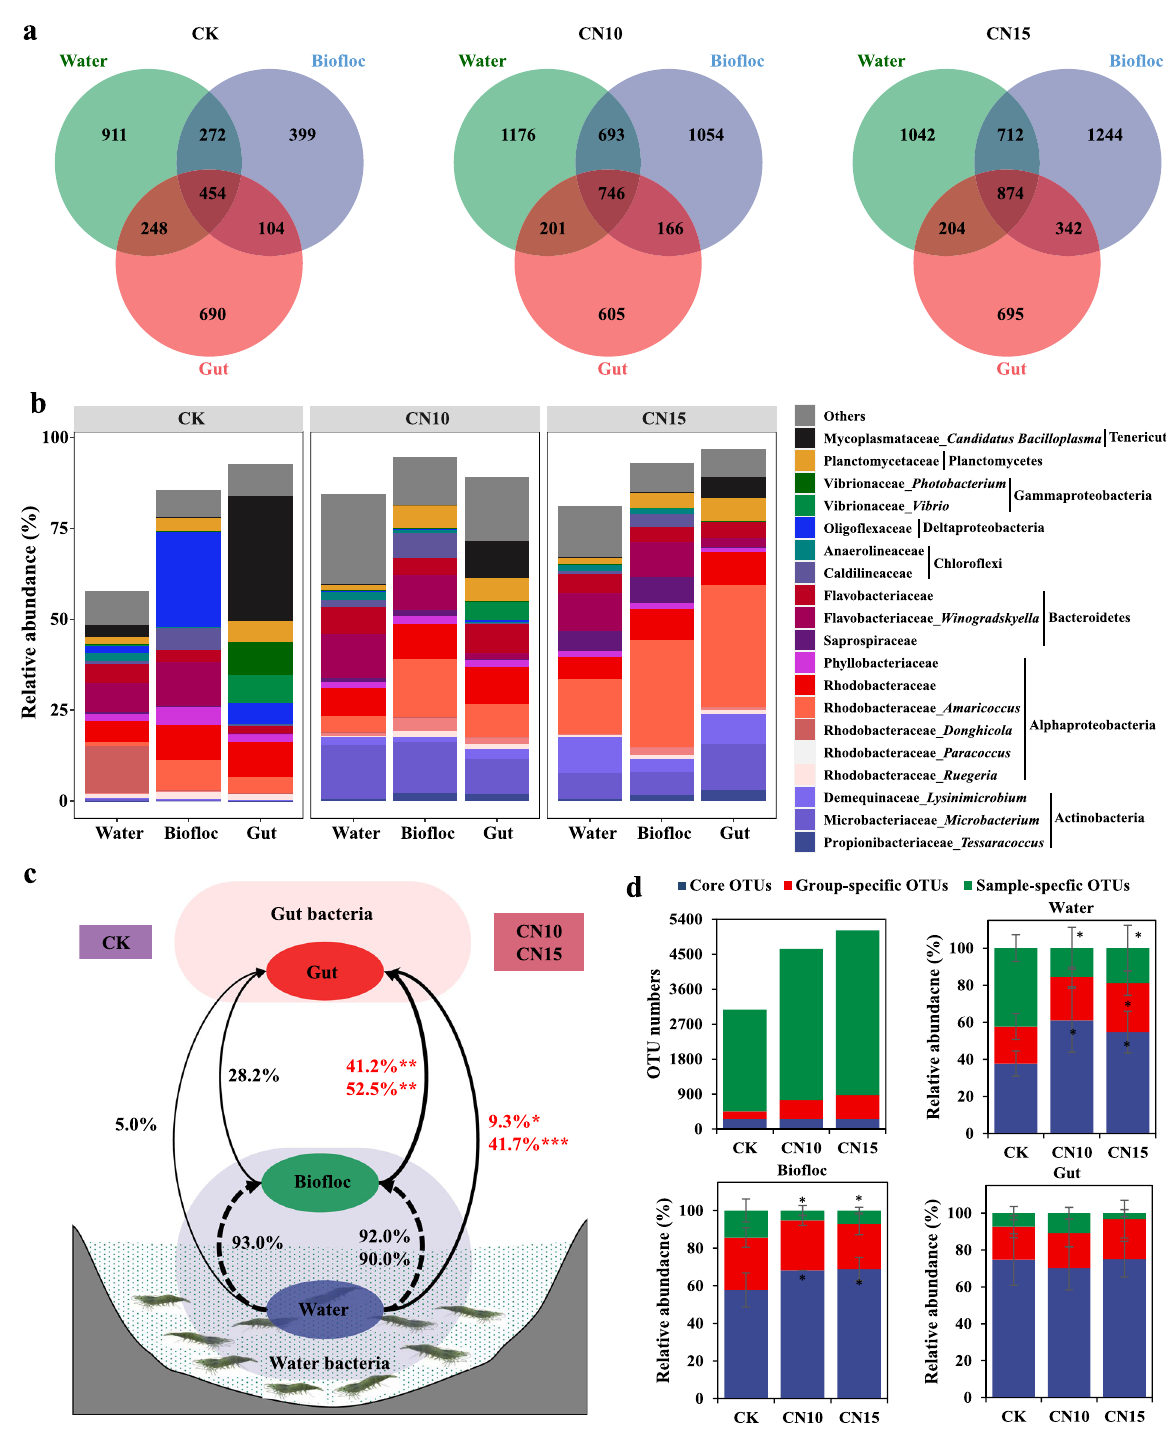
Fig. 2 Effects of sucrose addition on the bacterial community compositions of rearing water, bio fl oc, and gut in the shrimp culture systems. a Venn analysis of bacterial communities at the OTU level among rearing water, bio fl oc, and gut in control and sucrose addition culture systems. b The relative abundances of bacterial taxa at genus level shared by rearing water, bio fl oc, and gut in each culture system. c The percentage contributions of bacterial sources for bio fl oc and gut samples in each culture system based on the SourceTracker analysis. d The numbers and relative abundances of core and speci fi c OTUs in each culture system. CK: without sucrose addition; CN10: the C/N ratio of about 10:1 obtained by sucrose addition; CN15: the C/N ratio of about 15:1 obtained by sucrose addition. Each sample had six replicates ( n = 6), except the water samples ( n = 4) and bio fl oc samples ( n = 2) in control group. Error bars show standard error in ( d ). Different asterisks indicate a signi fi cant difference at * p < 0.05, ** p < 0.01, and *** p < 0.001 in ( c ) and ( d ) based on Student ’ s t